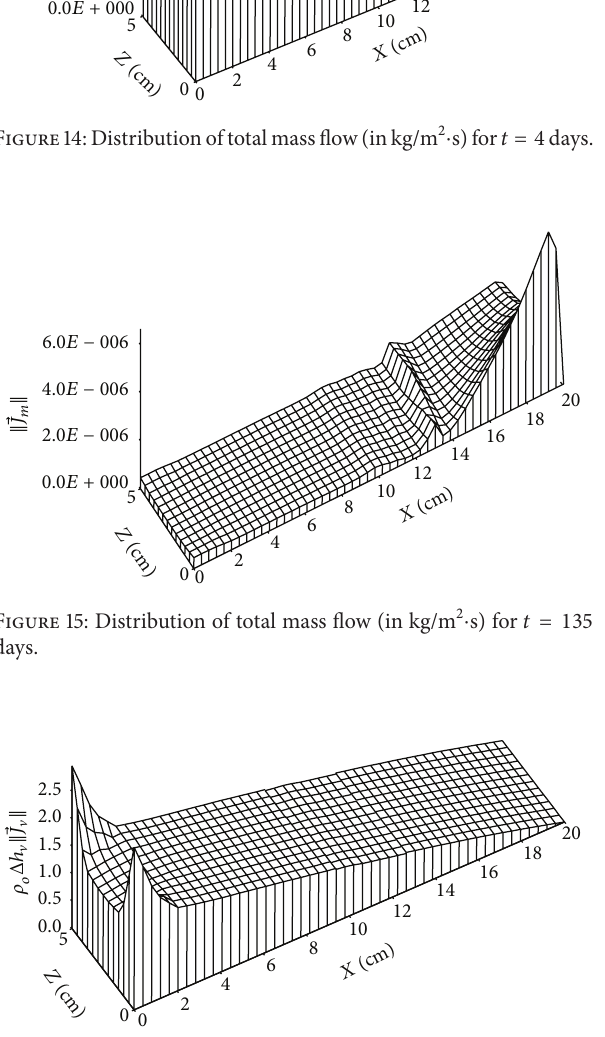
Figure 16: Distribution of heat flow due to phase change (in W/m 2 ) for 𝑡 = 4 days.